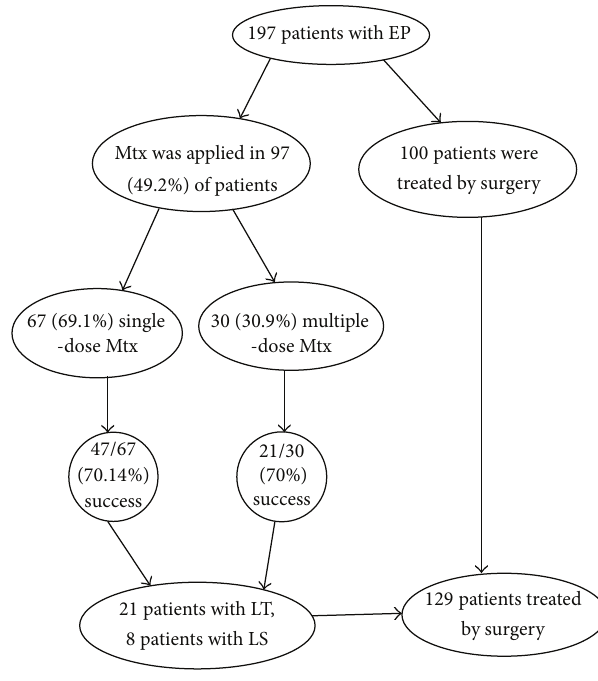
Figure 1: Flow of participants through the study. Table 2: Comparison of patient characteristics between single-dose and multiple-dose treatments with